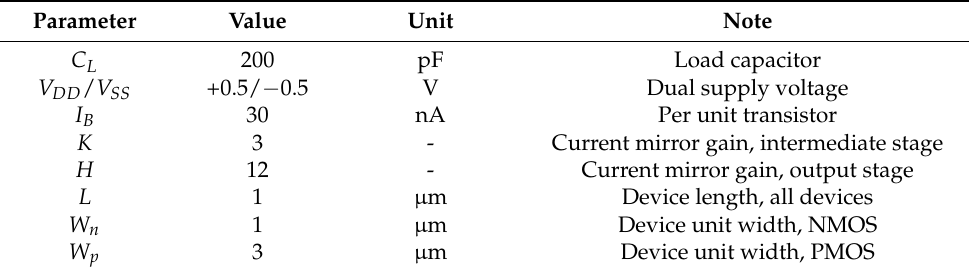
Table 1. Device sizing and design parameters.